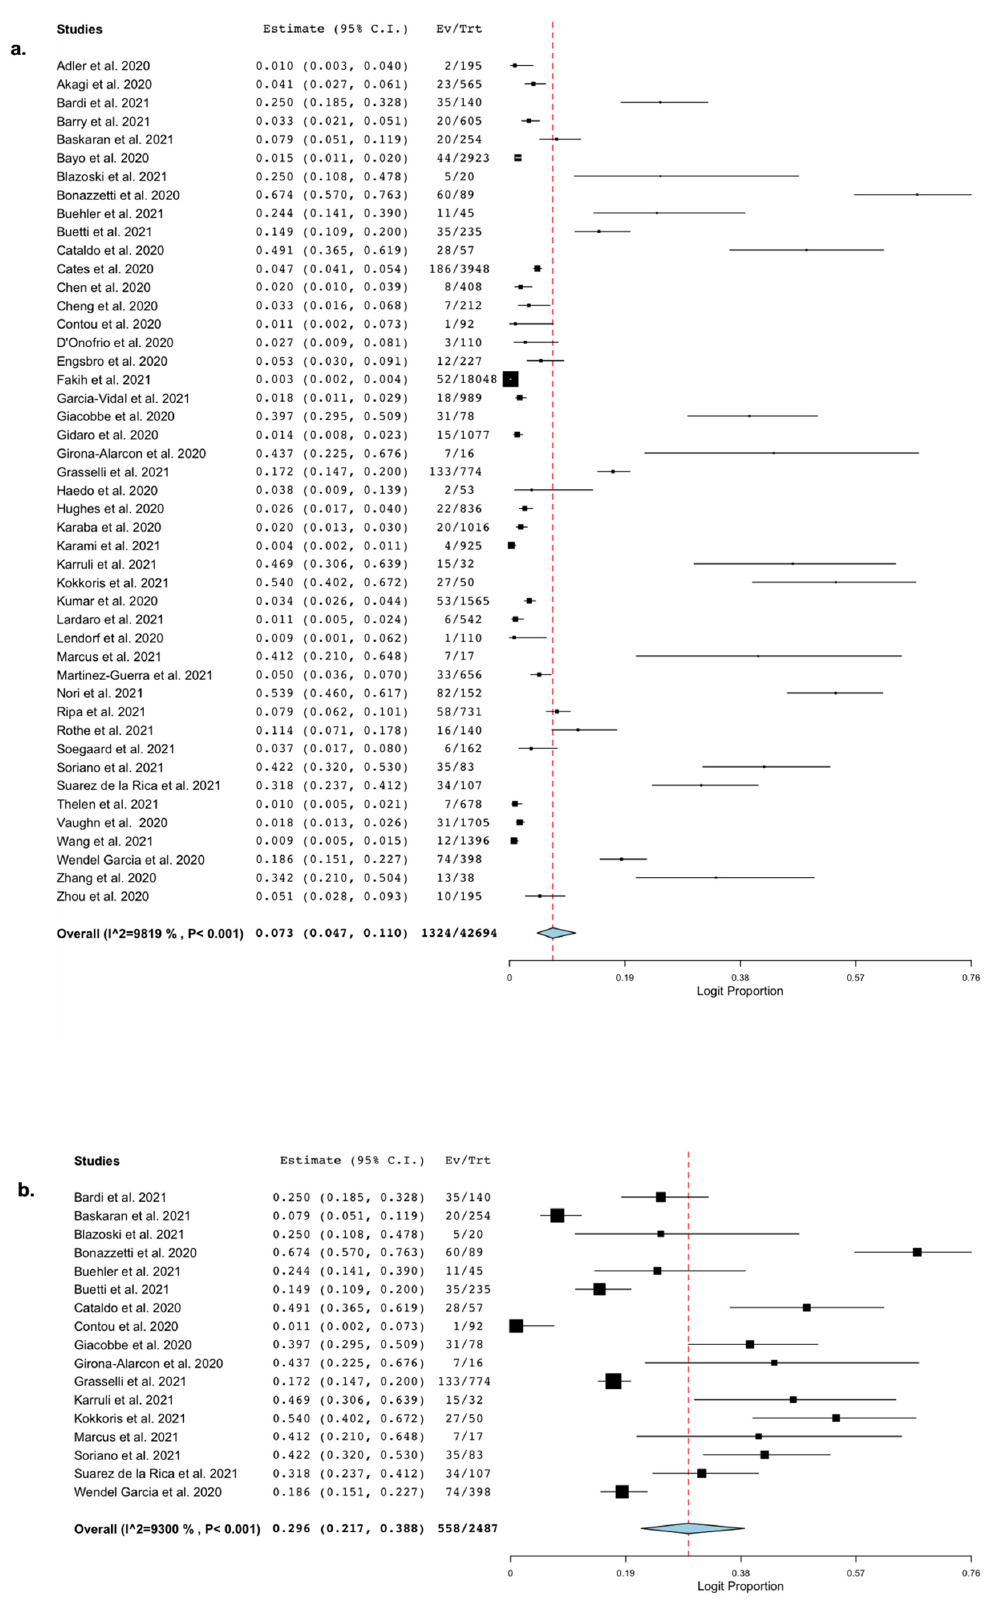
Figure 2. Occurrence of bloodstream infection. Forest plot with the result of single-arm meta-analysis for the occurrence of BSI in patients with COVID-19. BSI, bloodstream infection; CI, confidence interval; Ev, events; Trt, total. ( a ) Pooled estimated occurrence of bloodstream infection among hospitalized patients with COVID-19. ( b ) Pooled estimated occurrence of bloodstream infection among patients with COVID-19 admitted to